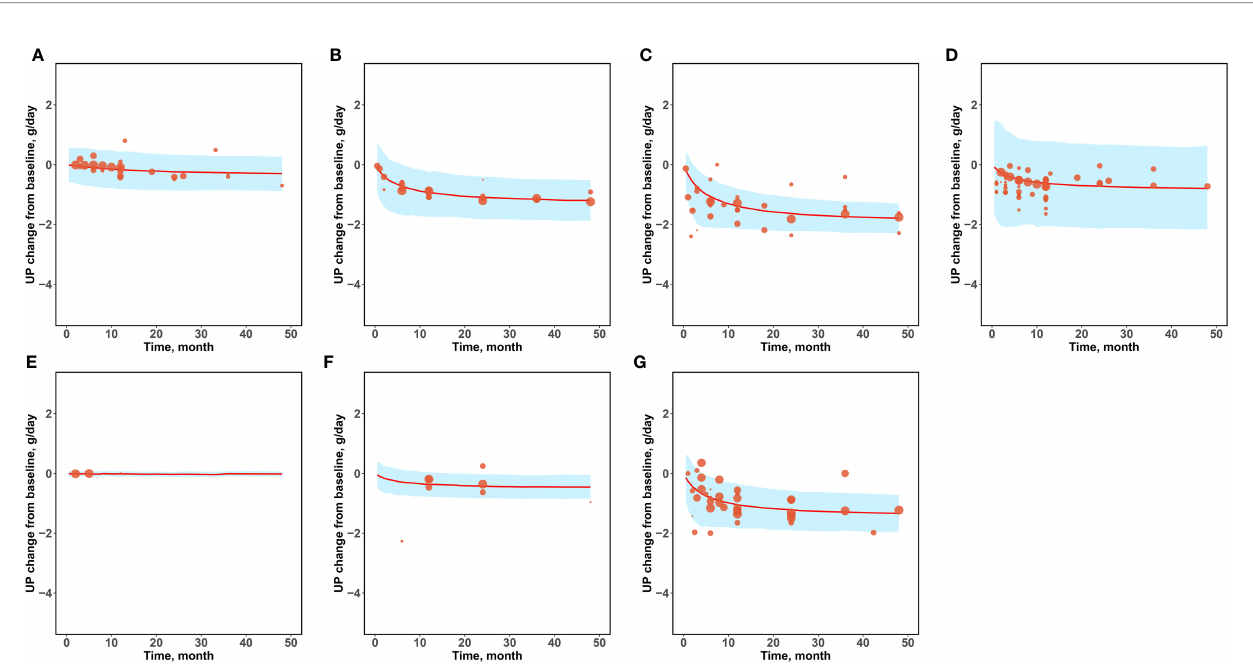
FIGURE 3 | Prediction-corrected visual predictive check. (A) Placebo (B) Corticosteroids (C) Immunosuppressants (D) RAS blockers (E) Antiplatelet agents (F) N-3 fatty acids (G) Other